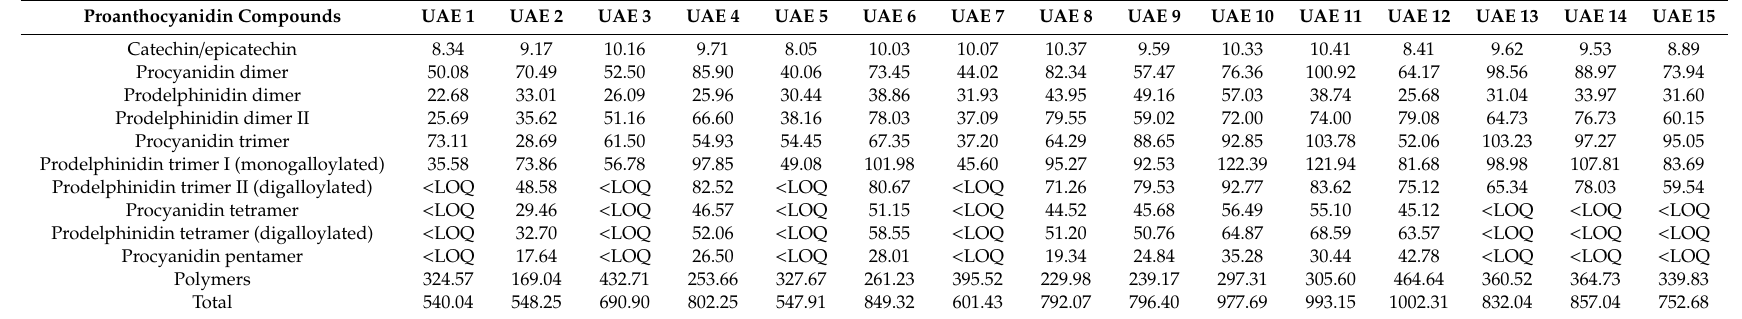
Table 3. Table of quantification of proanthocyanidins from brewers’ spent grain extracts by HPLC-FLD expressed as µ g · g − 1 d.w. UAE—ultrasound-assisted extraction; LOQ—limit of